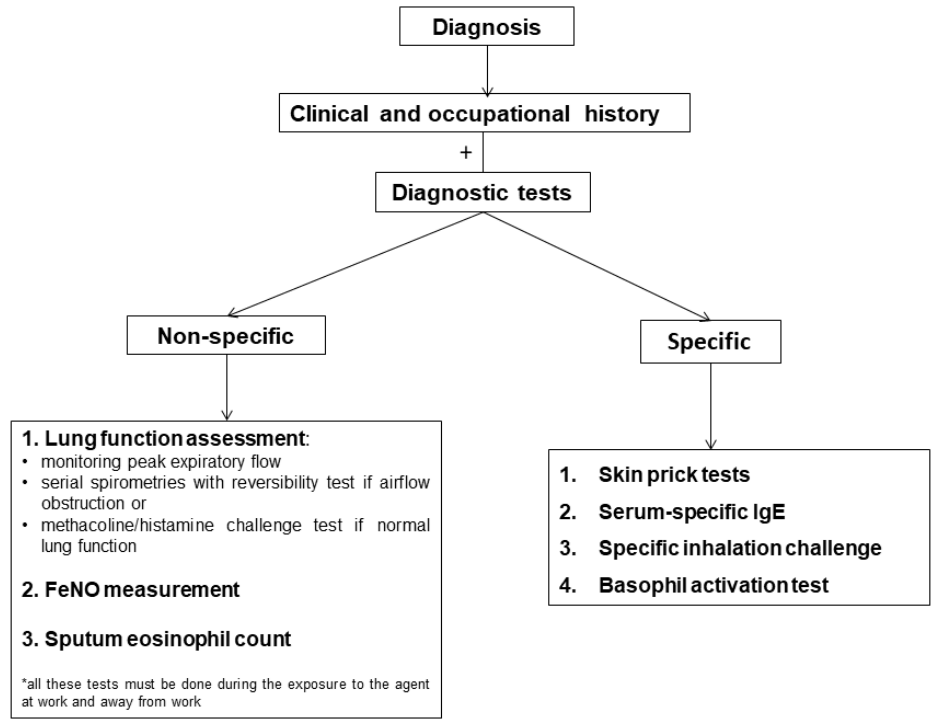
Figure 2. Diagnostic tests in occupational asthma.